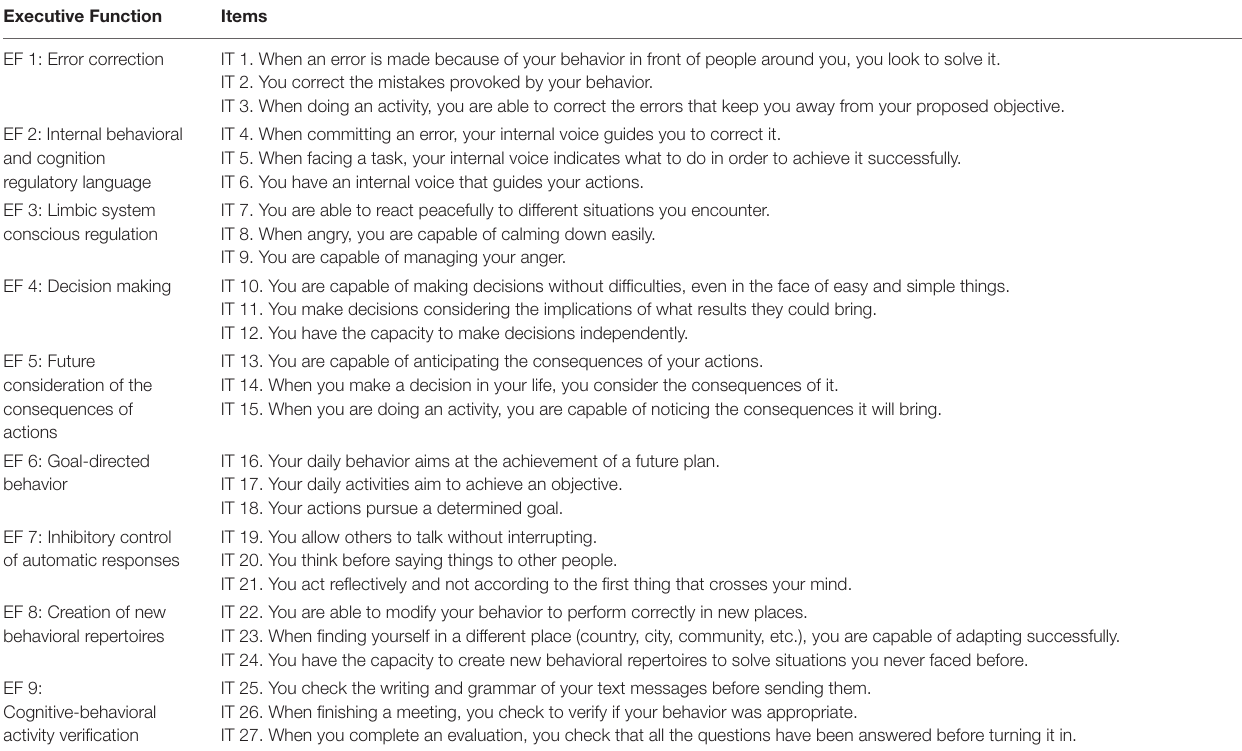
TABLE A1 | OECL-1 Scale (Ramos-Galarza et al.,